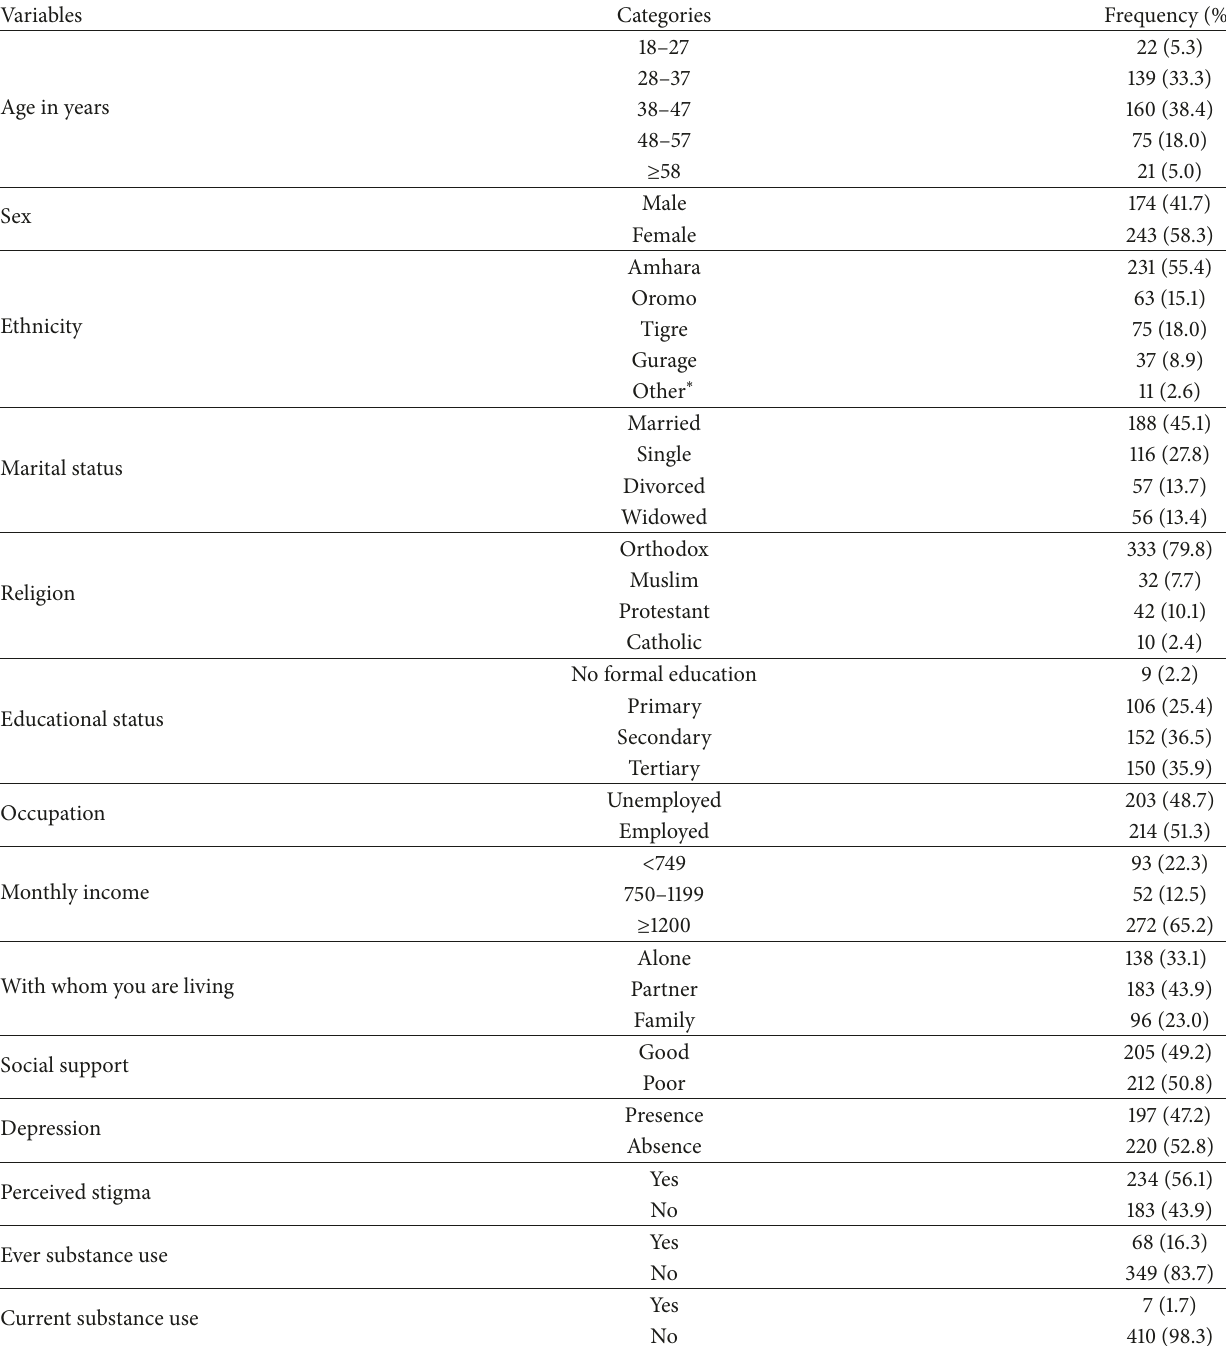
Table1:SociodemographiccharacteristicsofHIV-positivepeopleatZewdituMemorialHospital,AddisAbaba,Ethiopia,June2014 (𝑛 = 417)